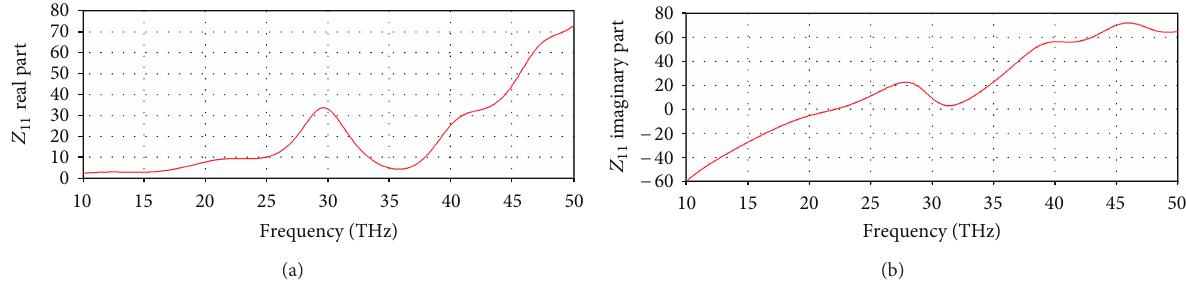
Figure 13: Input impedance of MCD antenna as a function of frequency: (a) resistance and (b) reactance.